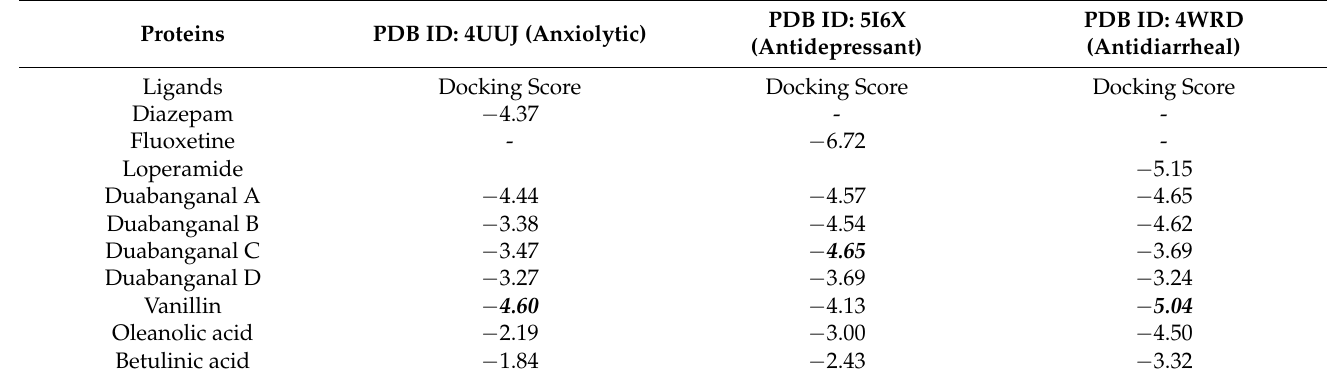
Table 5. Docking score (kcal/moL) of the specified bioactive isolates for anxiolytic, antidepressant, and antidiarrheal